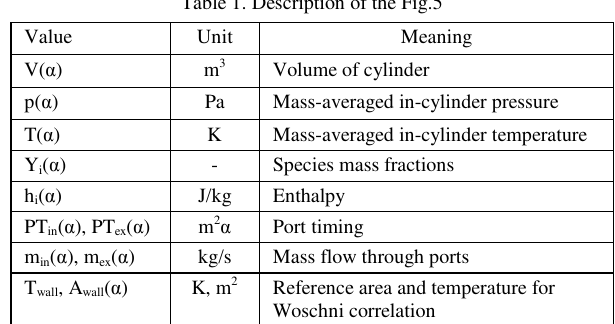
Table 1. Description of the